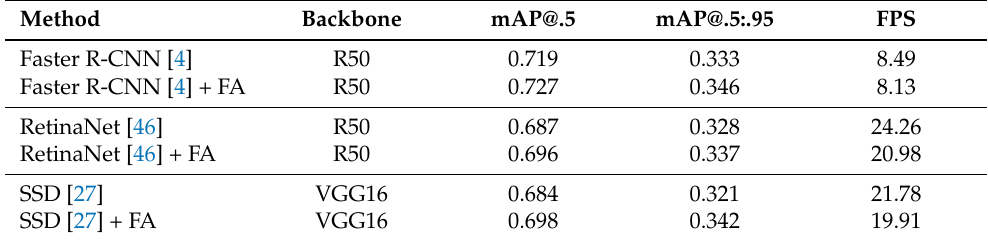
Table 6. Generalization of FA module applied to object detection